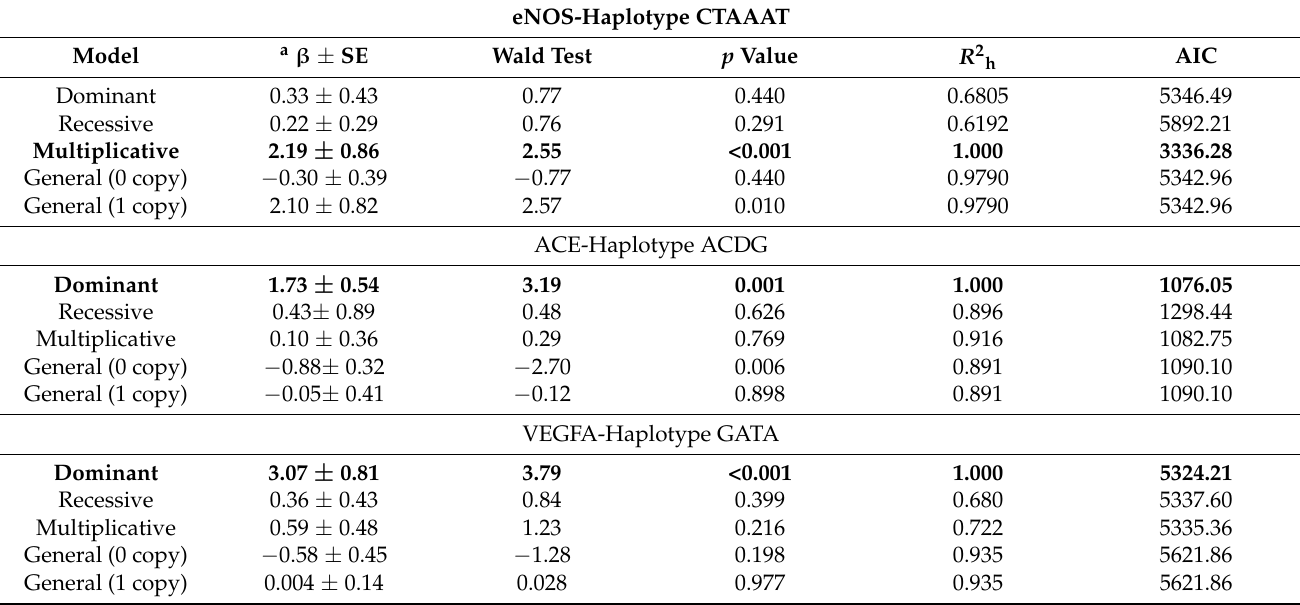
Table 8. Functional implications of susceptibility haplotypes and their impact in best fit model. eNOS-Haplotype